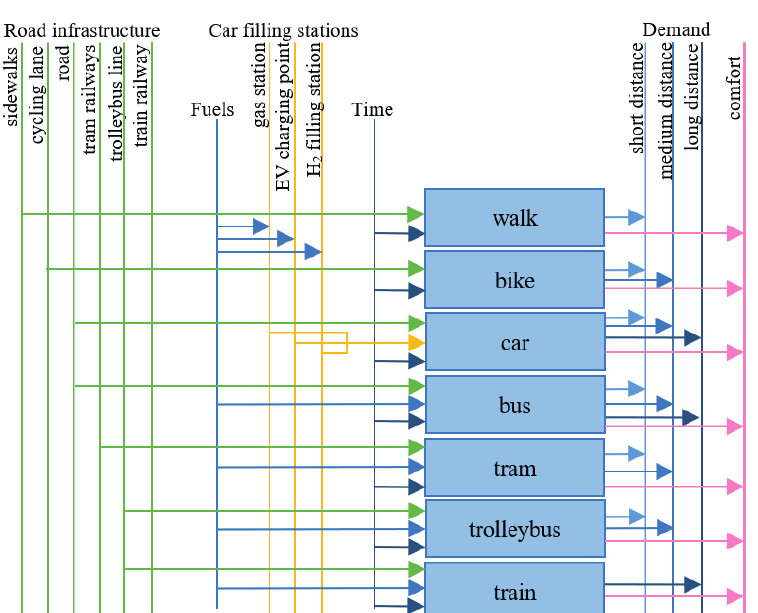
Fig. 2. Structure of passenger road transport in the model.